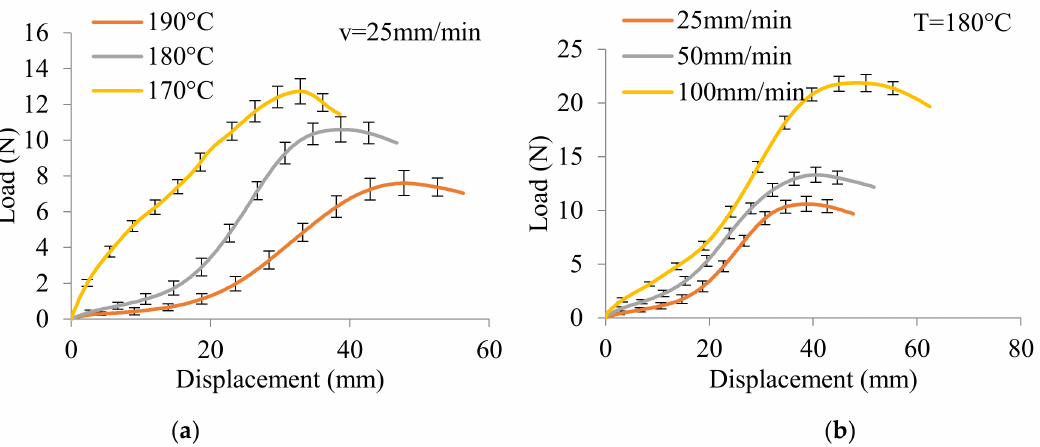
Figure 9. Load versus displacement curves of BR-B-AD at different thermo-conditions: